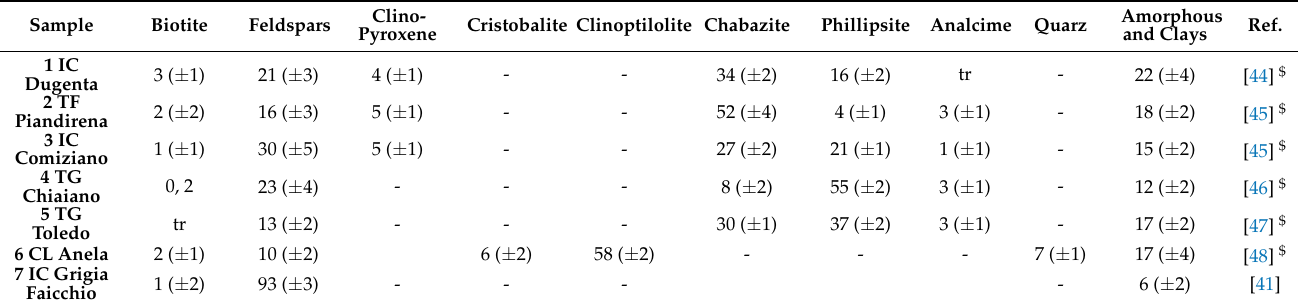
Table 1. Mineralogical composition of studied pyroclastic